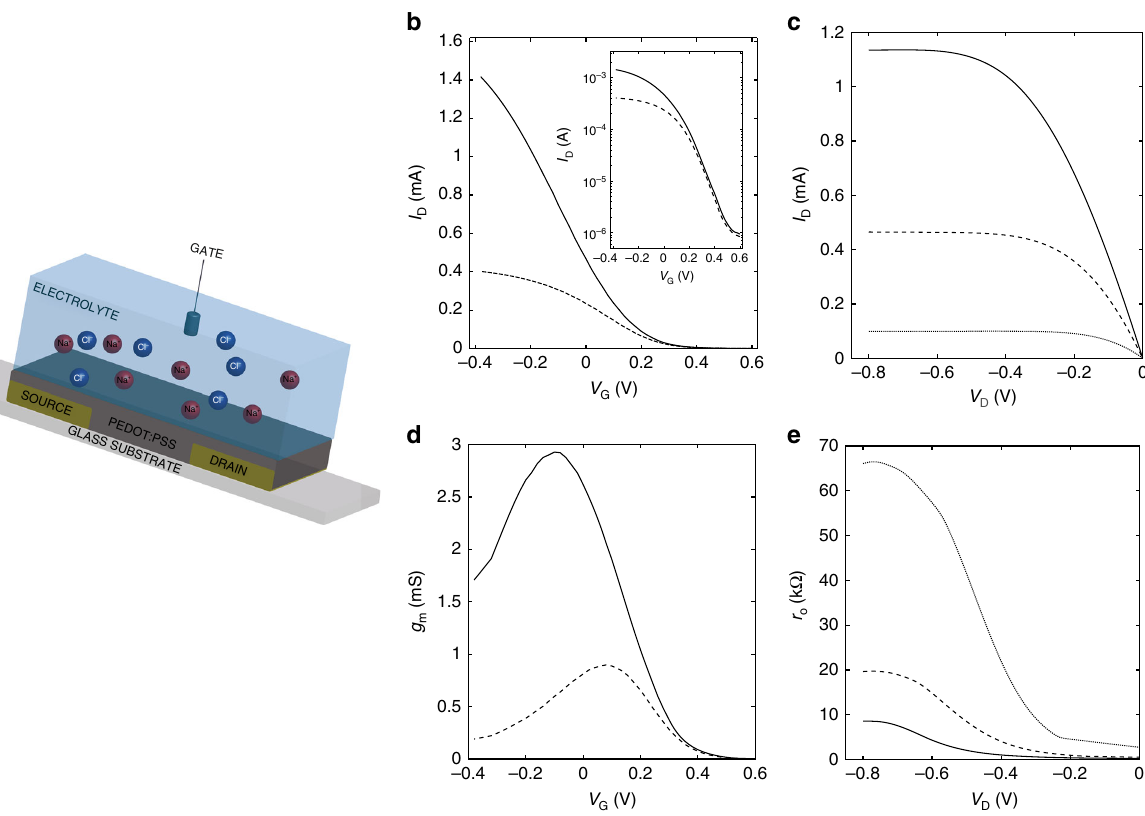
Fig. 1 Transistor architecture and electrical characteristics. a Schematic structure of the fabricated OECTs. b Transfer characteristics at V D = − 0.1 V (dashed line) and V D = − 0.4 V (full line). The gate current is lower than 1 µ A. c Output characteristics at V G = 0.2 V (dotted line), V G = 0 V (dashed line), and V G = − 0.2 V (full line). d Transconductance at V D = − 0.1 V (dashed line) and V D = − 0.4 V (full line). e Output resistance at V G = 0.2 V (dotted line), V G = 0 V (dashed line), and V G = − 0.2 V (full line). The gate is an Ag/AgCl pellet and the OECTs geometries are: W = 1000 µ m, L = 50 µ m, t = 50 nm. The NaCl concentration is 1